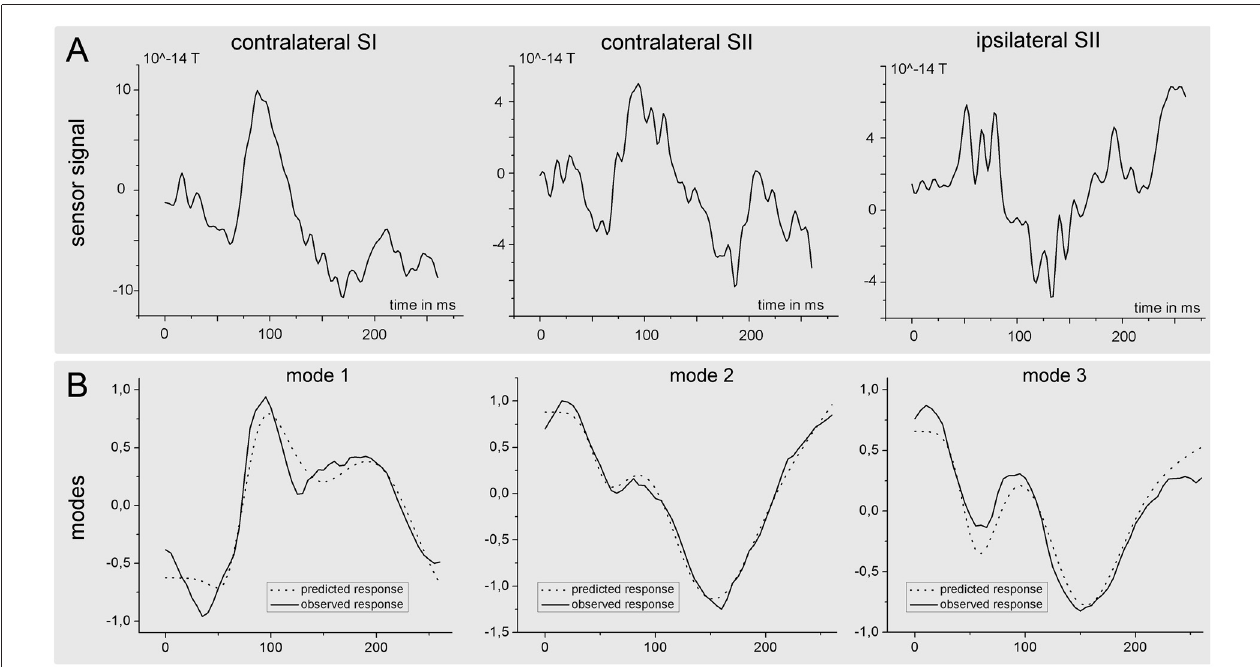
FIGURE 8 | Time course of the source activity and sensor readings of a single subject. The upper row (A) of the figure shows the measured signal at the sensor level for one single subject. The signal was estimated as the mean (preprocessed) signal of the four sensor channels nearest to the source. The lower part (B) of the figure shows predicted (dotted) and observed (solid) responses in measurement space for the first three spatial modes, which were obtained after projection of the sensor data onto seven spatial modes.